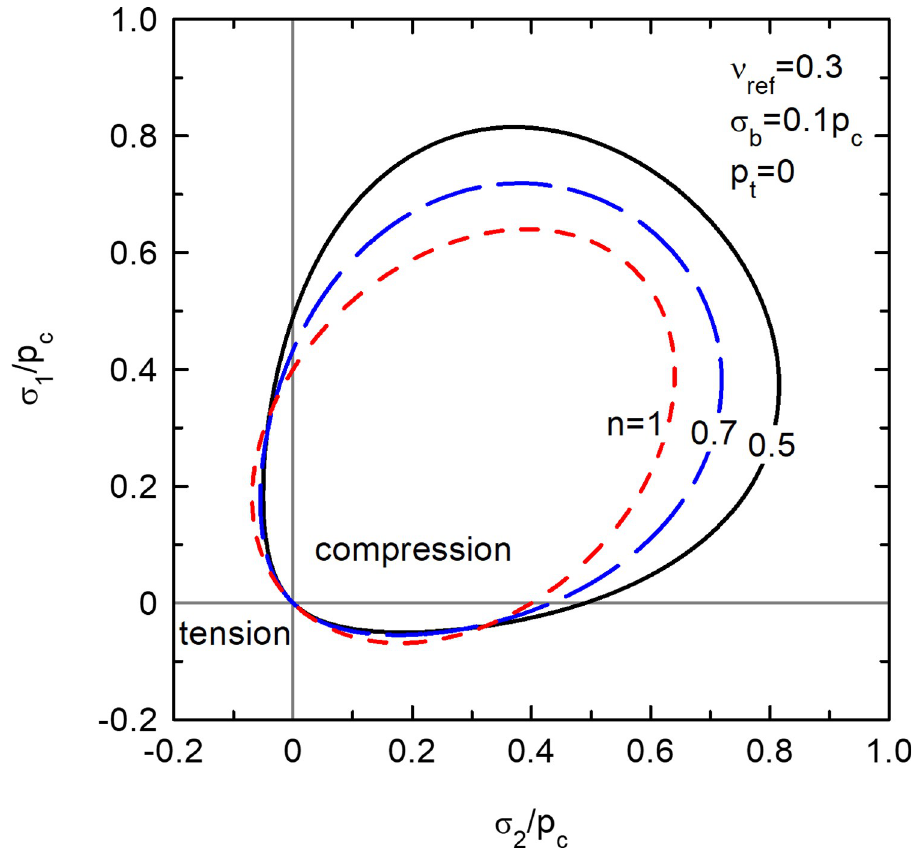
Fig 9. Biaxial non-linear elastic potentials ( σ 3 =